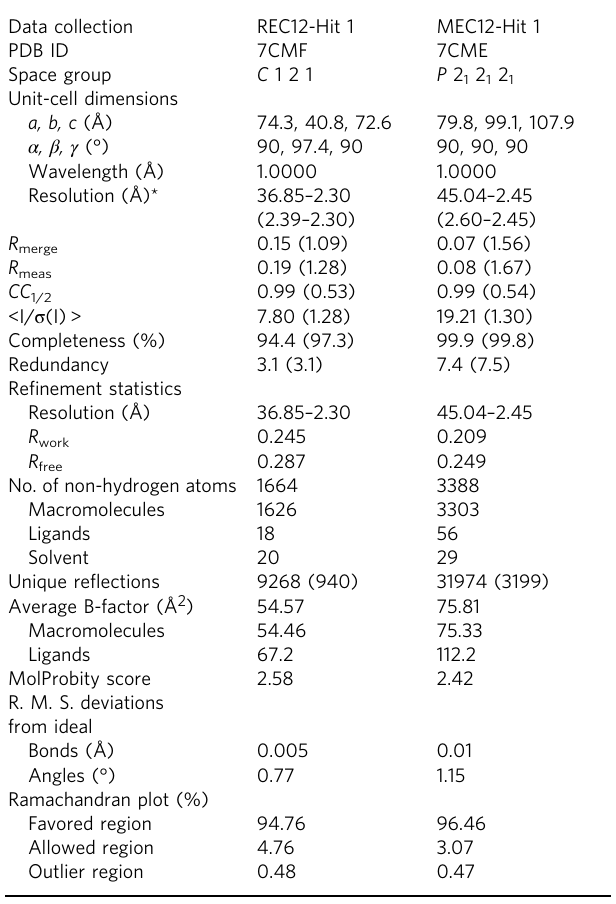
Table 1 Crystallographic data collection and re fi nement